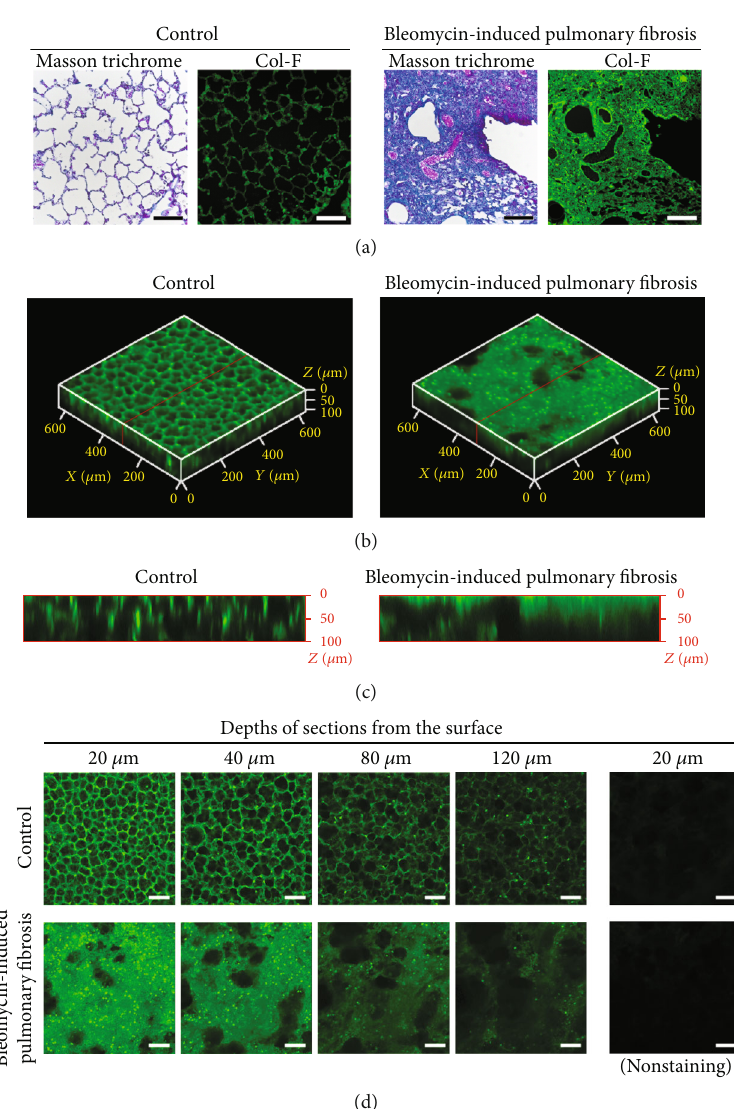
Figure 6: Fluorescence labeling of fi brotic foci in the lungs using Col-F. (a) Lung sections were stained using Col-F. Green fl uorescence indicates the localization of Col-F. Scale bar is 100 μ m. (b – d) Fibrotic lungs were perfusion- fi xed, excised, and stained using Col-F. After Clear T2 tissue-clearing treatment, the lungs were observed using confocal microscopy. (b) Three-dimensional images were reconstructed from single-plane images. Each 5 μ m stack is 20 – 120 μ m below the lung surface. (c) The image of cross-sections indicated by the red lines in (b). (d) Single-plane images at the indicated depth ( μ m) from the lung surface. Green fl uorescence indicates the localization of Col-F. The scale bar is 100 μ